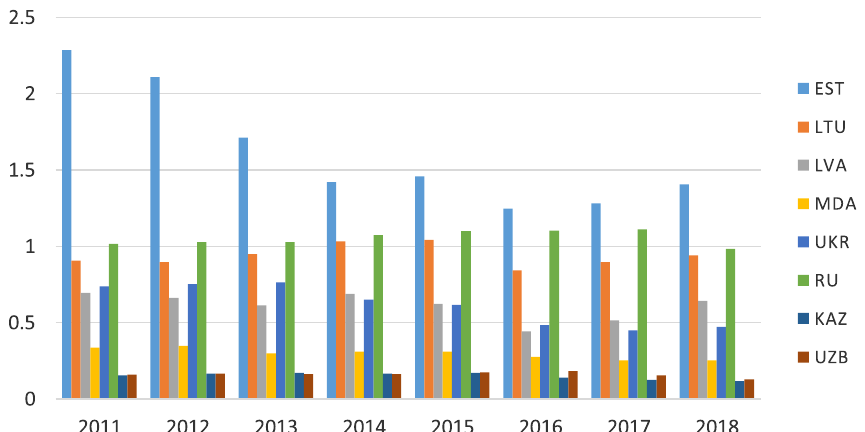
Figure 2. The share of R&D expenditure in GDP in post-Soviet countries in 2011–2018. As for the number of researchers, in Estonia and Lithuania, it slightly increases by the end of the study period, while in Latvia, on the contrary, it slightly decreases (Figure 3). In Ukraine, Moldova, Russia and Uzbekistan, the number of researchers is gradually decreasing. In Kazakhstan, one can note a sharp increase in the number of researchers between 2011 and 2012 (almost 1.6 times). Further, the annual growth in the number of researchers continues until 2015, after which the decline